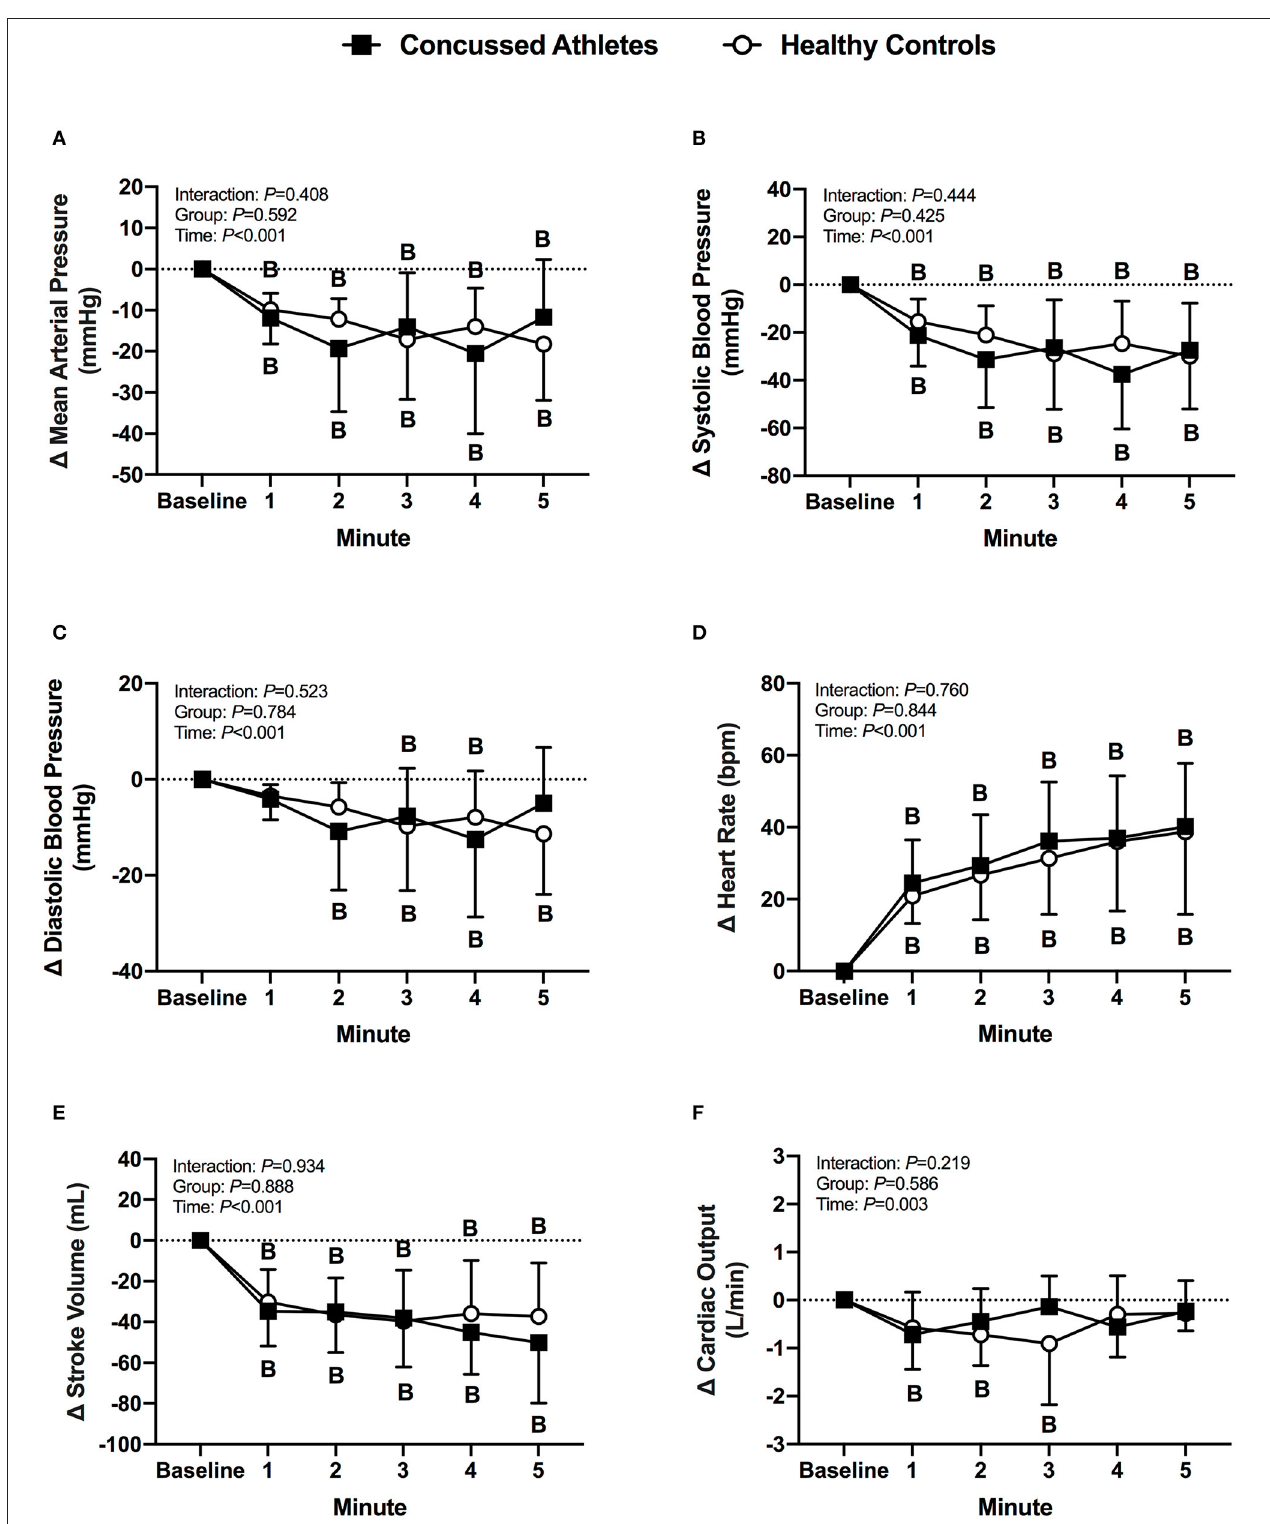
FIGURE 1 | The change from baseline in mean arterial pressure (A) , systolic blood pressure (B) , diastolic blood pressure (C) , heart rate (D) , stroke volume (E) , and cardiac output (F) at each minute of LBNP for concussed athletes ( n = 10) and healthy controls ( n = 10). Participants who experienced pre-syncopal signs and did not last the full minute are not included in the statistics for that time point. Concussed athletes were excluded at 3min ( n = 4), 4min ( n = 5), and 5min ( n = 7). Healthy controls were excluded at 3min ( n = 1) and 4min ( n = 2). B, different from Baseline, ( P ≤ 0.05).